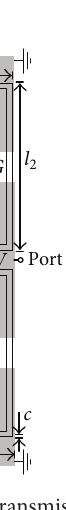
Figure 3: Lumped element equivalent circuit model of a periodic structure composed of a cascade of SRR-loaded CPW unit cells, including magnetic coupling between resonators of adjacent cells; model with mutual inductance between resonators (a), transformed model (b), and four-portunitcellmodelindicatingtheportvoltagesandcurrentsrelativetothecalculationofthetransfer ABCD matrix.From[34],reprinted with permission.